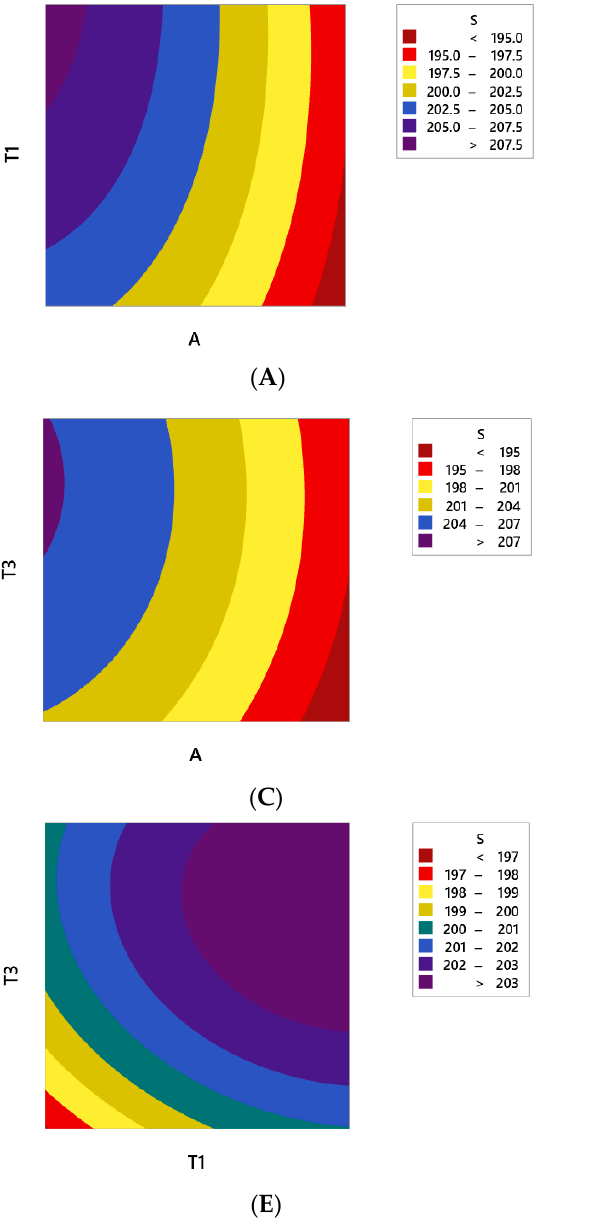
iations of the fiber angle and the wall-thickness of the top and bottom sections, ( B ) variations of the fiber angle and the wall-thickness of the middle section, ( C ) variations of the fiber angle and the wall-thickness of the main section, ( D ) variations of the wall-thickness of the top and bottom sections and the wall-thickness of the middle section, ( E ) variations of the wall-thickness of the top and bottom sections and the wall-thickness of the main section, and ( F ) variations of the wall-thickness of the middle section and the wall-thickness of the main section (all symbols are defined in Table 3).